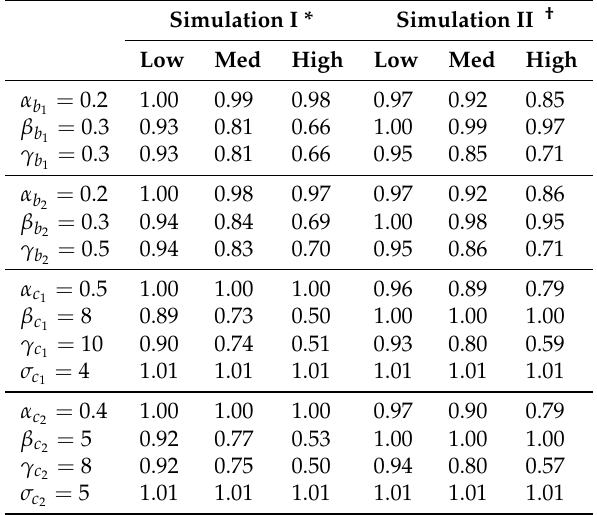
Table 1. The ratio of the mean squared error (MSE) of the multivariate mixed response model (MMR) to the marginal model (GLM). Results based on 1000 independent simulation under two different scenarios and three different levels of